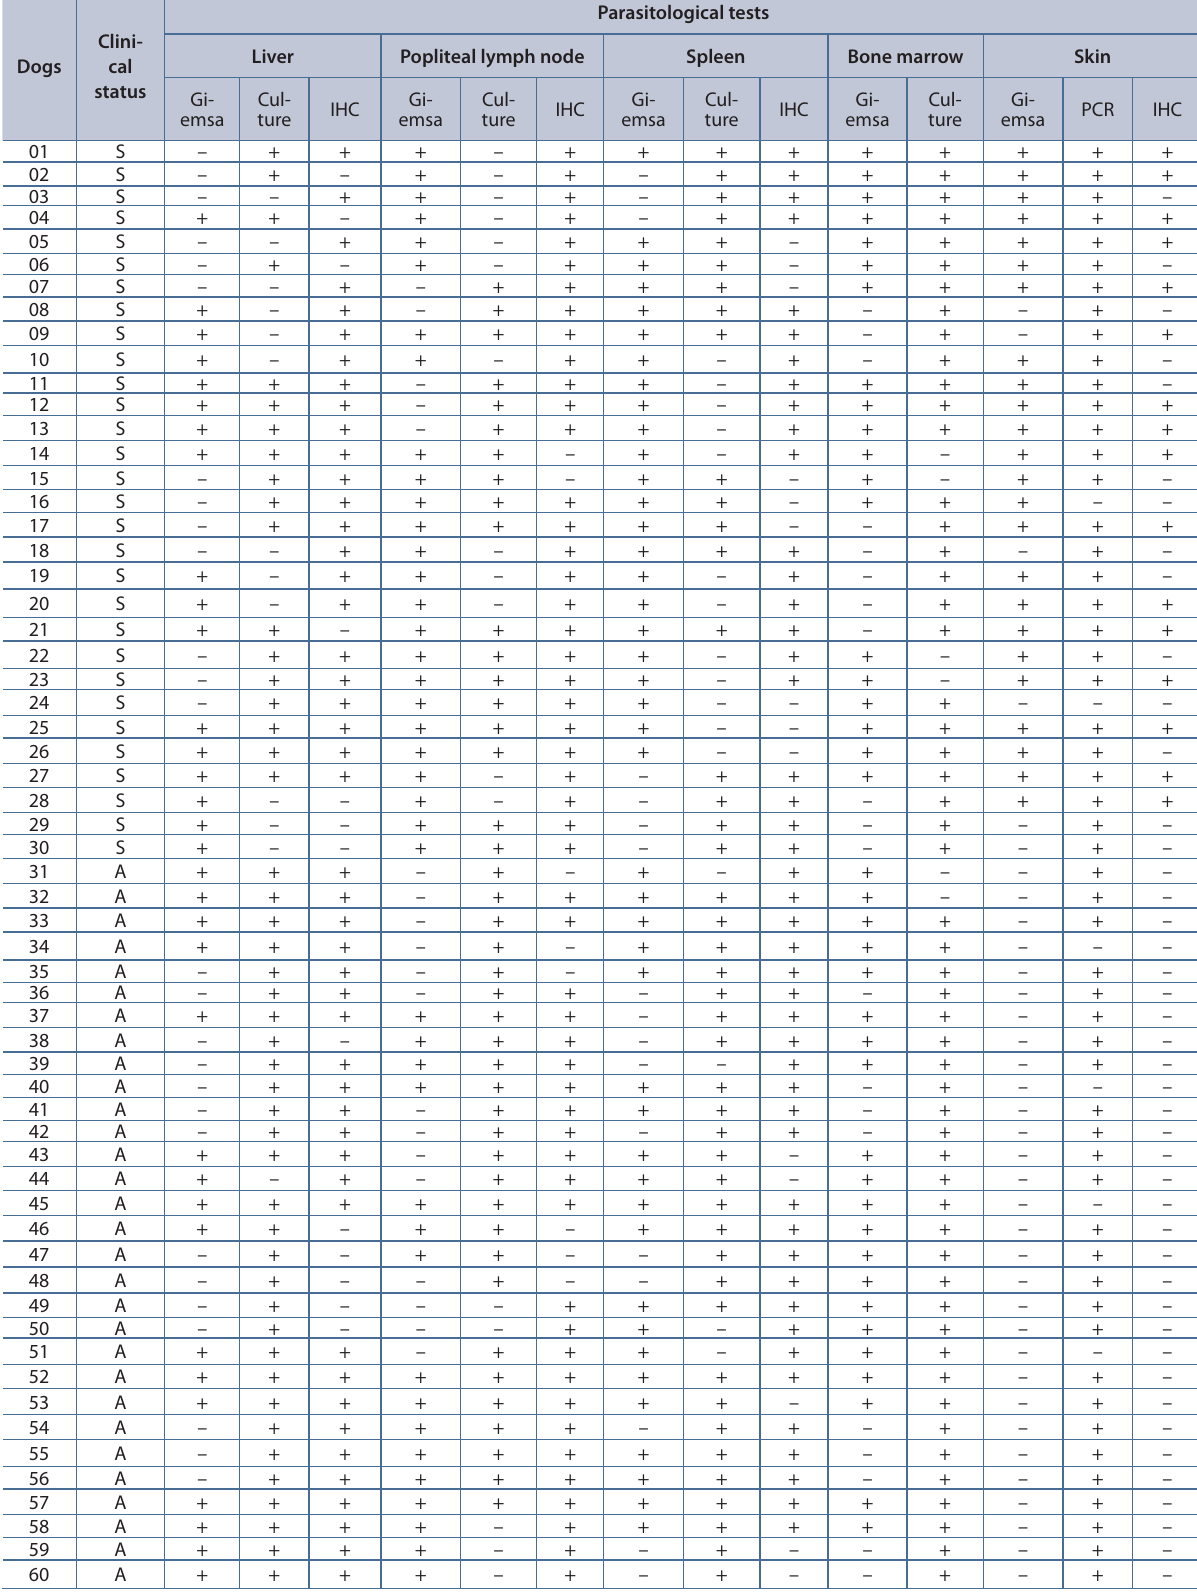
Table 2. Parasitological tests (Giemsa, culture, PCR and immunohistochemistry) performed in different organ samples according to clinical status of dogs naturally infected with Leishmania (L.) chagasi (n = 60)